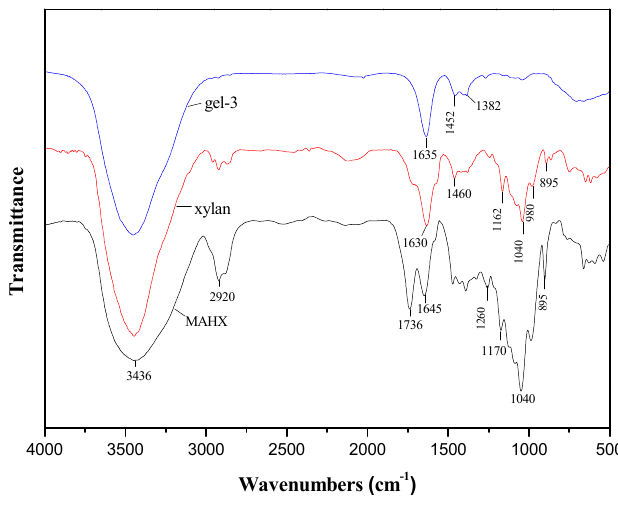
Figure 4. Fourier-transform infrared (FTIR) spectra of xylan, MAHX, and